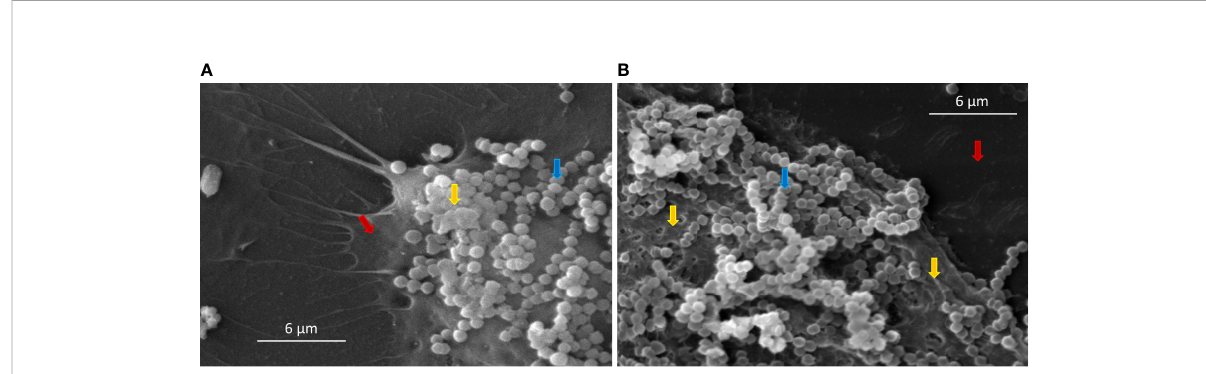
FIGURE 2 Scanning electron microscopy (SEM) of SDSD bio fi lms formed by VSD13 after (A) 2 h and (B) 4 h on human keratinocyte cells. Blue arrow: SDSD VSD13 cells; yellow arrow: formation of the extracellular polymeric matrix; red arrow: human keratinocyte